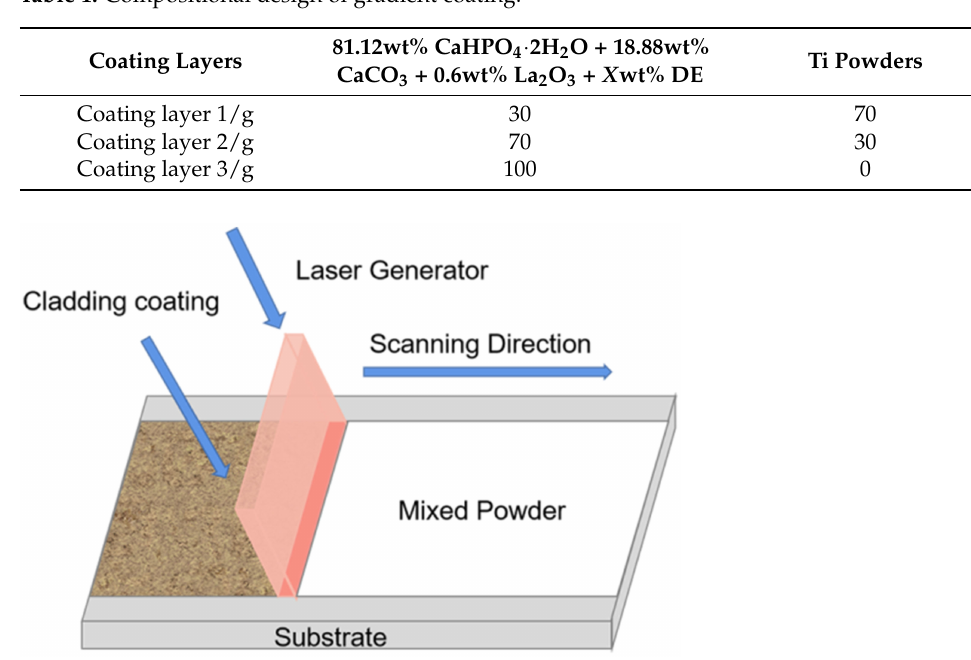
Table 1. Compositional design of gradient coating.